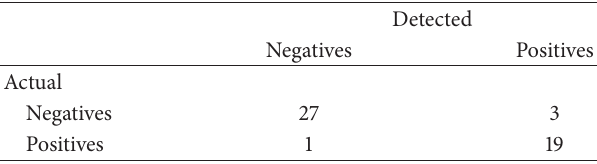
Table 4: Training, test, and validation set for nipple detection.